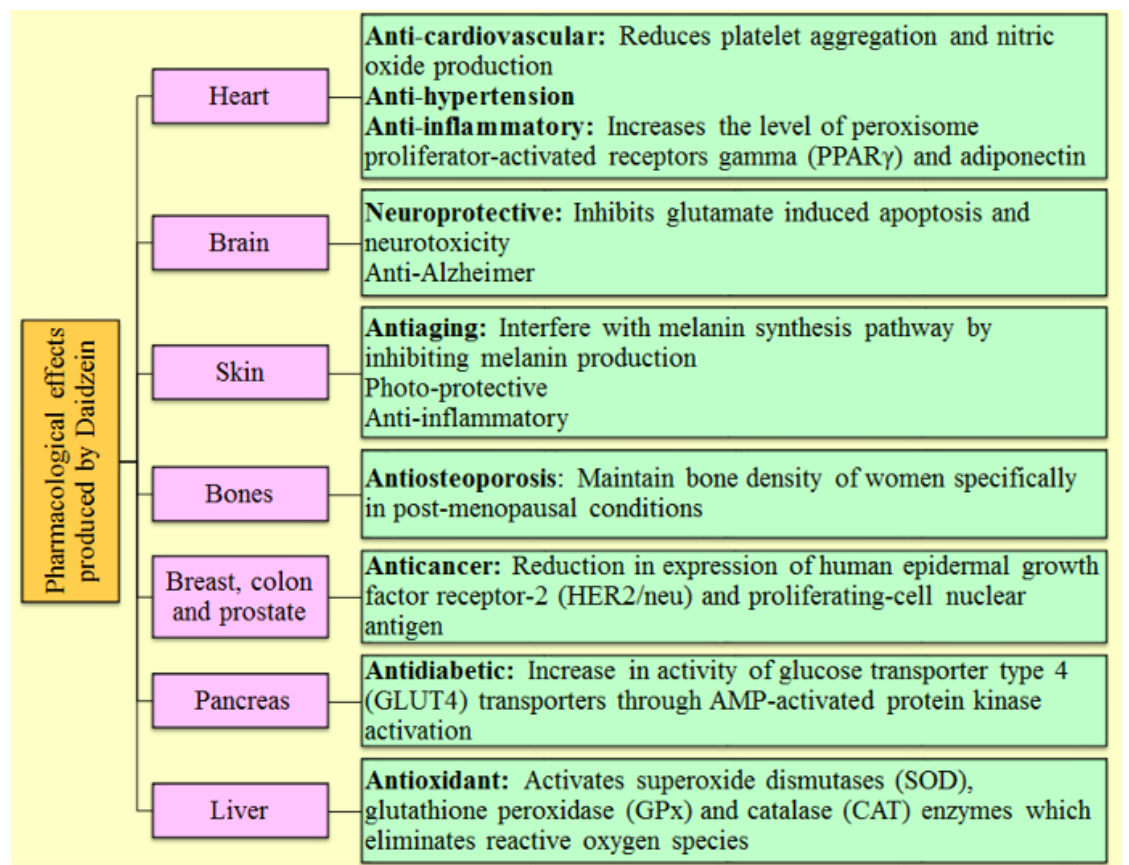
Figure 2. Representation of several pharmacological activities of Daidzein and their mechanism of action involved in various body organs.